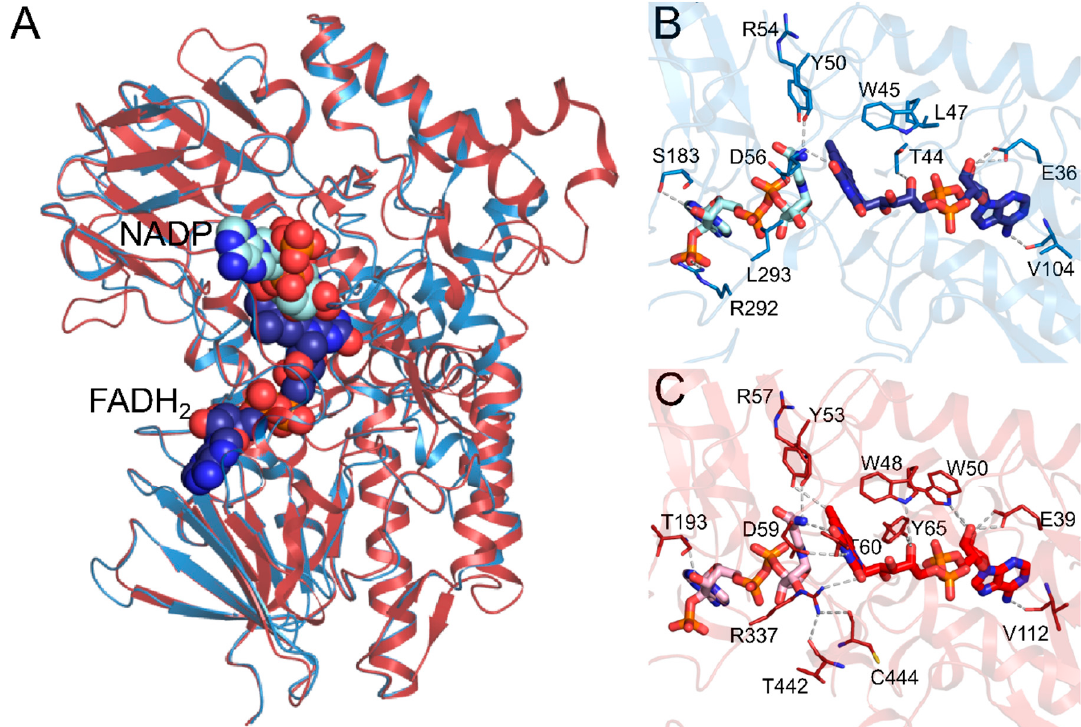
Figure 2. 3D structure and active site of EthA and 3UOZ. ( A ) Structural alignment between the EthA model (blue) and 3UOZ (red) FADH 2 (blue) and NADP (cyan) are represented by spheres. The FADH 2 and NADP binding region is shown for ( B ) EthA and ( C ) OTEMO.